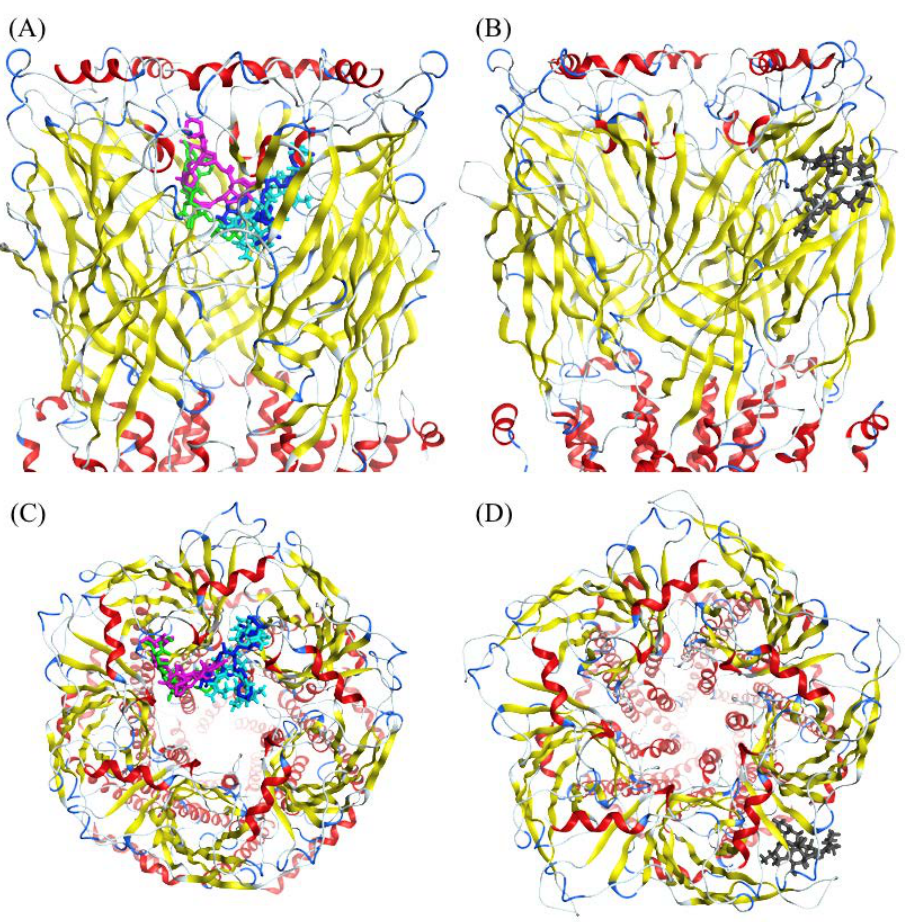
Figure 4. Binding poses of ivermectin (dark blue), doramectin (purple), okadaic acid (green), con-